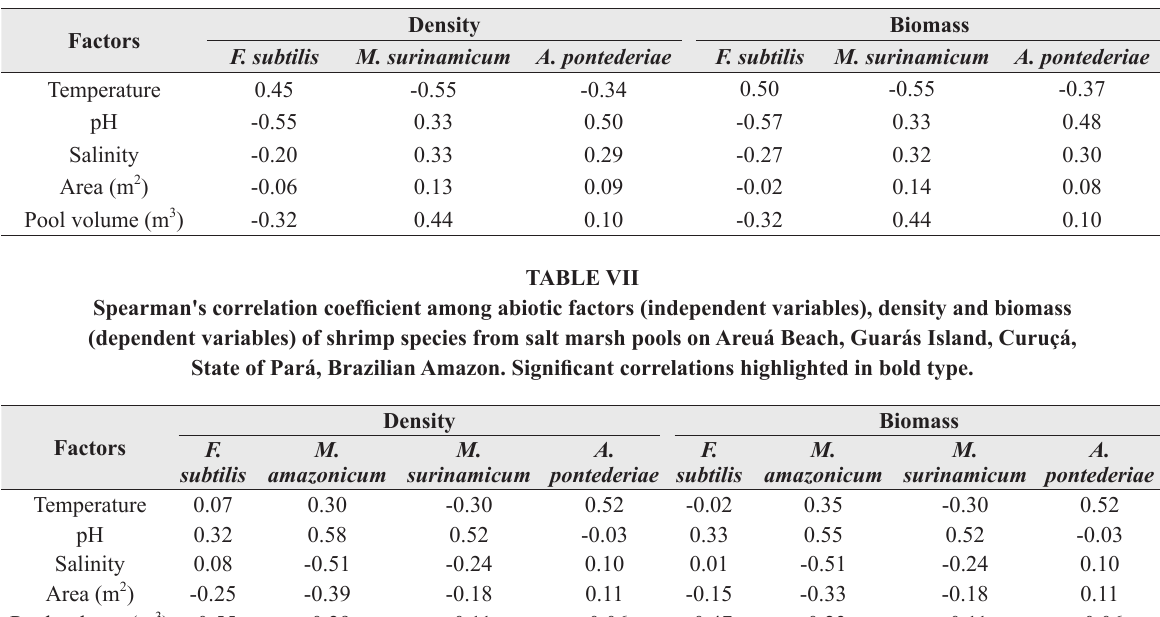
Spearman's correlation coefficient among abiotic factors (independent variables), density and biomass (dependent variables) of shrimp species from rocky outcrop pools on Areuá Beach, Guarás Island, Curuçá, State of Pará, Brazilian Amazon. Significant correlations highlighted in bold type.